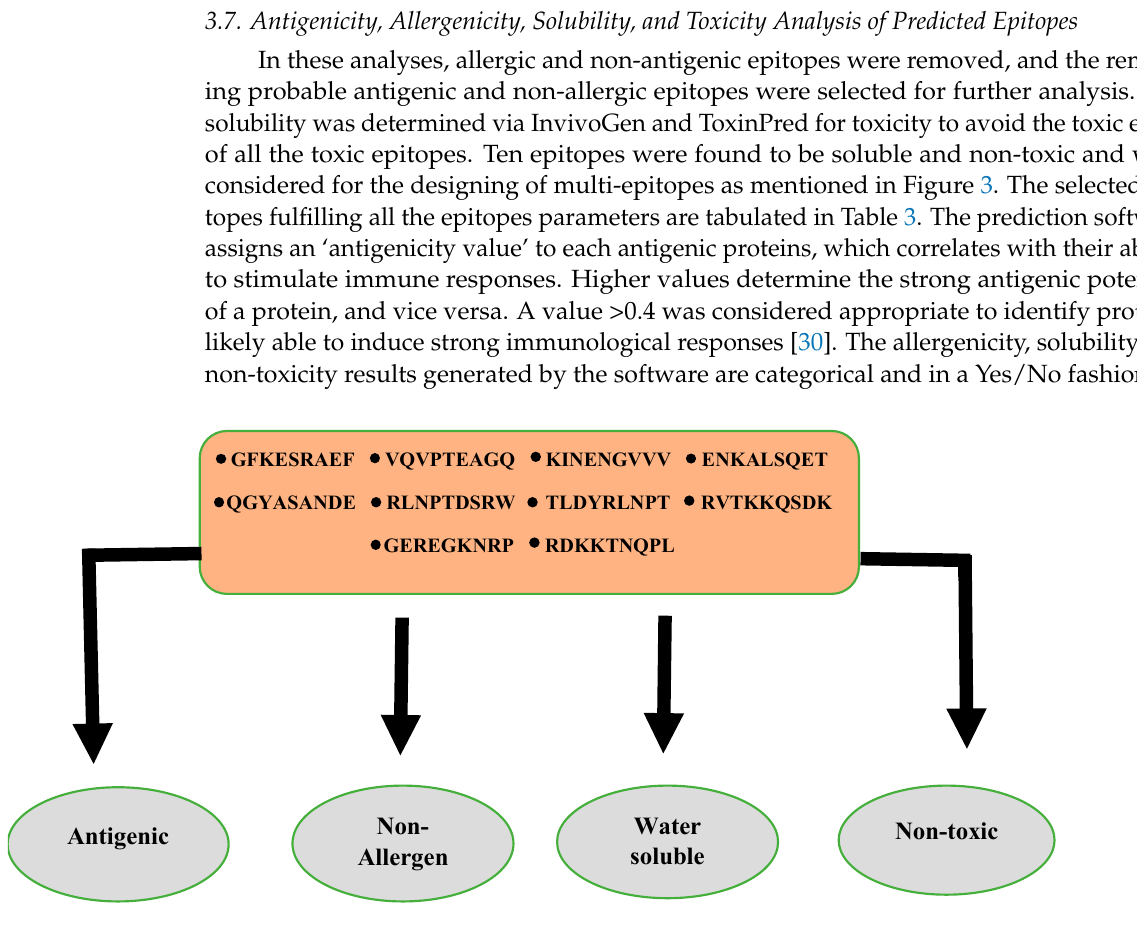
Figure 3. Final 10 shortlisted epitopes used for construction of a multi-epitopes-based vaccine. Table 3. Determination of antigenicity, allergenicity, solubility, and toxicity of predicted epitopes.